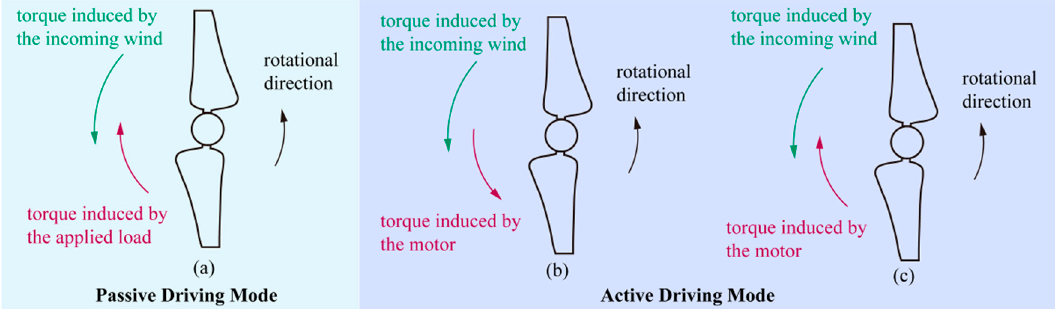
Figure 5. Torque contributions acting on the turbine rotor, not accounting for the mechanical friction: ( a ) PDM; ADM in conditions where the real-time angular speeds is lower ( b ) or higher ( c ) than the prescribed angular speed.